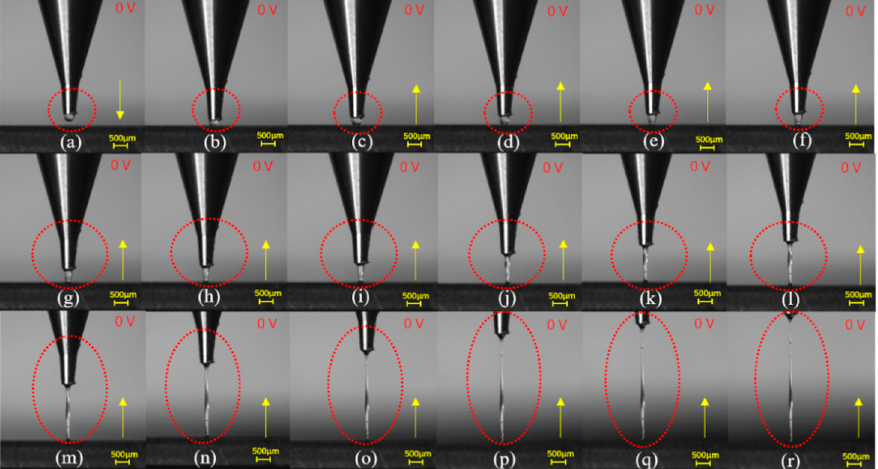
Figure 4. Vertical tensile morphology of jet at 0 V DC voltage. ( a ) the meniscus initially formed at the bottom of the nozzle; ( b ) the PCL material at the bottom was bonded to the surface of the deposited substrate; ( c – i ) the shape and size of the jet flow show obvious taper changes; ( j – m ) the spindle shape appeared in the middle of the jet; ( n – r ) the jet size became finer, and there was a tendency to fracture.